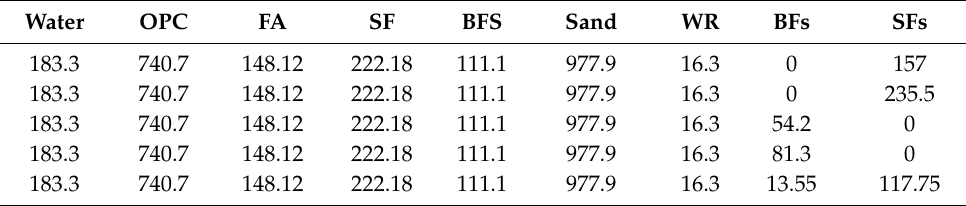
Figure 1. The manufacturing and measuring processes. Table 3. Mix proportion of RPC per unit volume (kg/m 3 ). Table 3. Mix proportion of RPC per unit volume (kg/m 3 ).